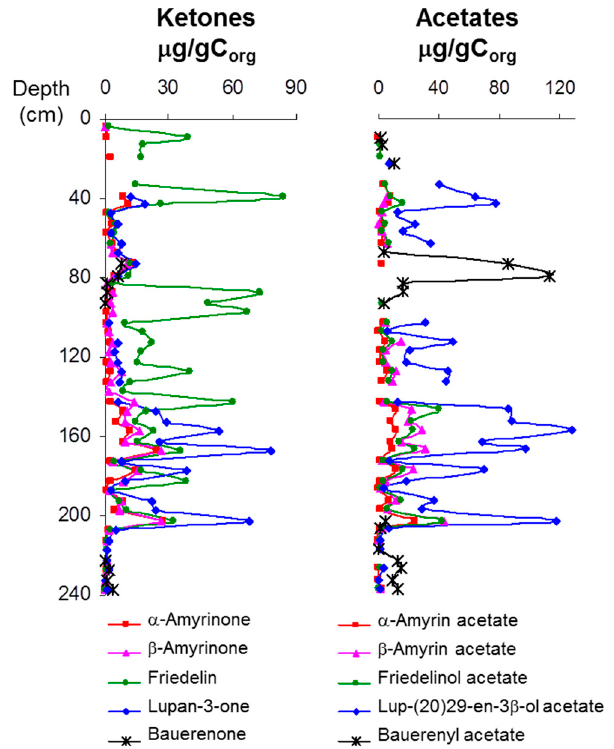
Figure 4. Variation of the concentration of higher plant triterpenoid ketones and acetates in the Roñanzas profile ( μ g/g Corg).